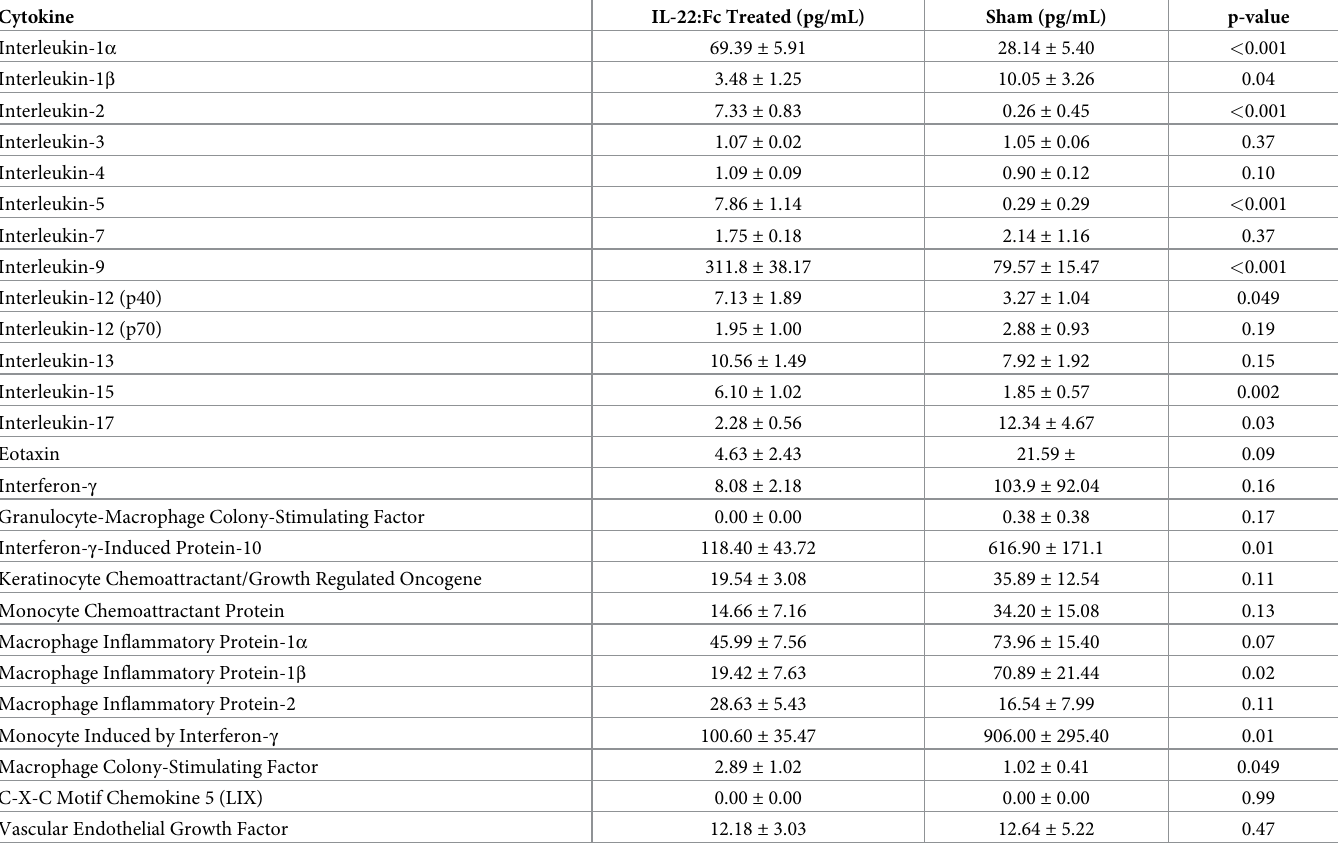
Table 3. A comparison of IL-22:Fc treated and sham animals after acute lung injury with high dose LPS.